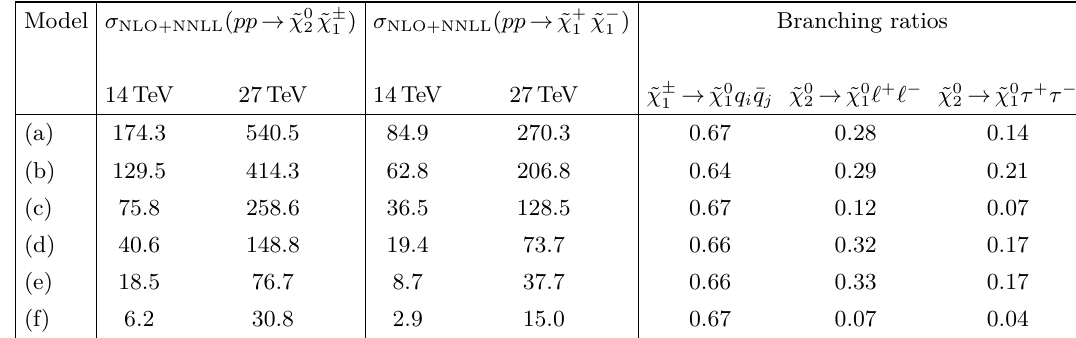
The NLO+NNLL production cross-sections, in fb, of electroweakinos: the second neutralino-chargino pair, ˜ χ 0 ˜ χ ± (second and third columns), and opposite sign chargino pair (fourth 2 1 √ √ and fifth columns) at s = 14 TeV and at s = 27 TeV for benchmarks (a)–(f) of table 6. Also shown are the branching ratios to quarks and leptons for the electroweakinos of the same bench- marks. Note that q ∈ { u, d, c, s } and ‘ ∈ { e, µ }